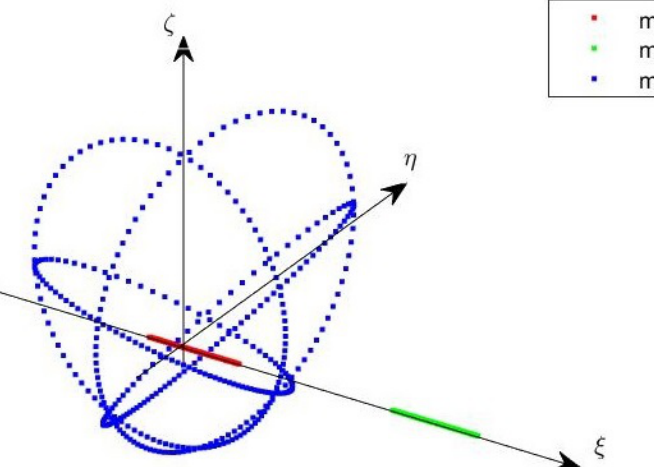
Figure 1. Motion of the primaries in the rotating frame.